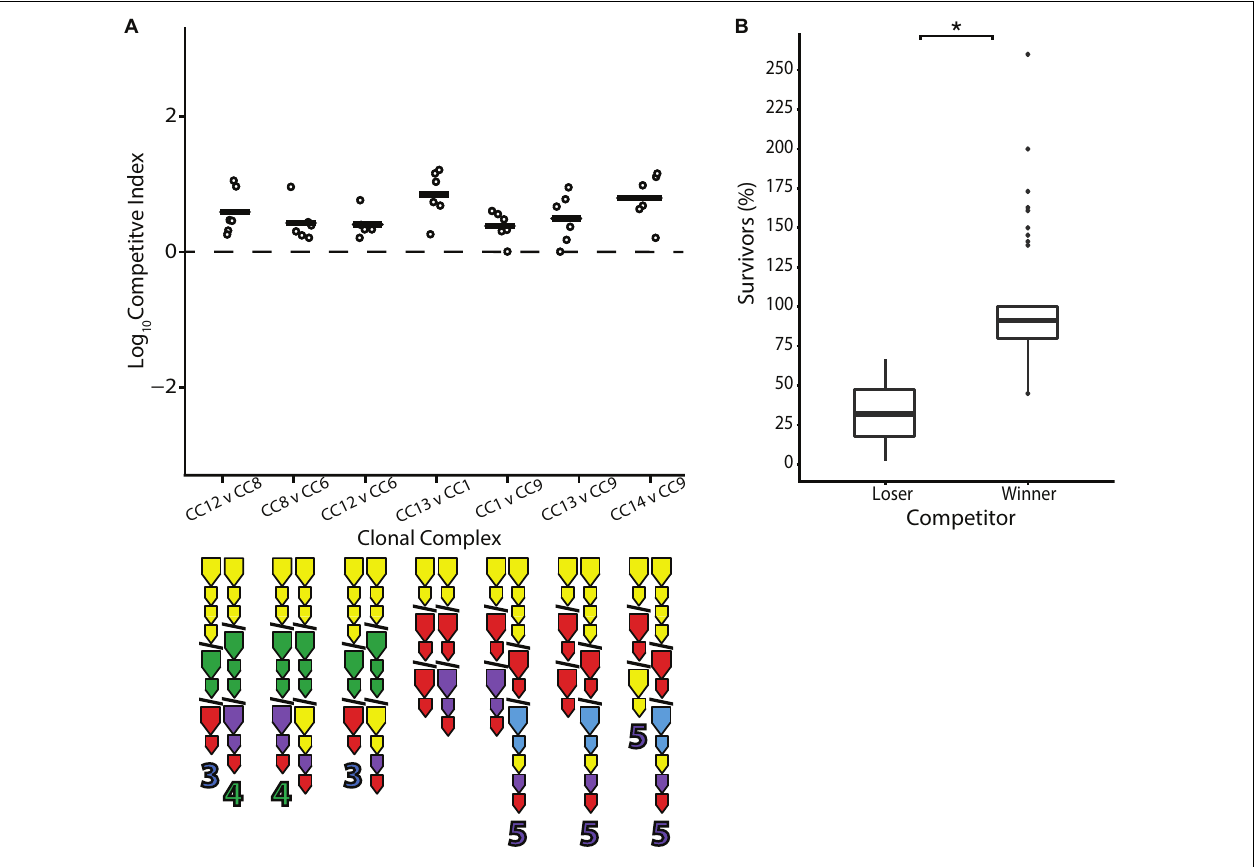
FIGURE 4 | Orphan immunity genes confer an advantage in pairwise competition. Strains differing only in orphan immunity gene composition were competed in equal concentration at 25 ◦ C over 4 h. (A) Dots indicate the log competitive index for each replicate ( N = 6), with the average shown as a bar on the y -axis, with a positive CI indicating a favorable competitive outcome for the second strain in the competition. All CI values were statistically significant based on a two-tailed, one-sample Student’s t test ( p < 0.05). E-I module composition is indicated below strain names. (B) Percentage of surviving cells compared to the original input of losing and winning strains in individual competitions. Box-and-whiskers plots show median, 25th and 75th percentiles (upper and lower hinges), and 1.5 interquartile range (whiskers). Outliers are shown as individual dots. Asterisk indicates statistically significantly different means between the anticipated losing and winning groups (unpaired t test p <